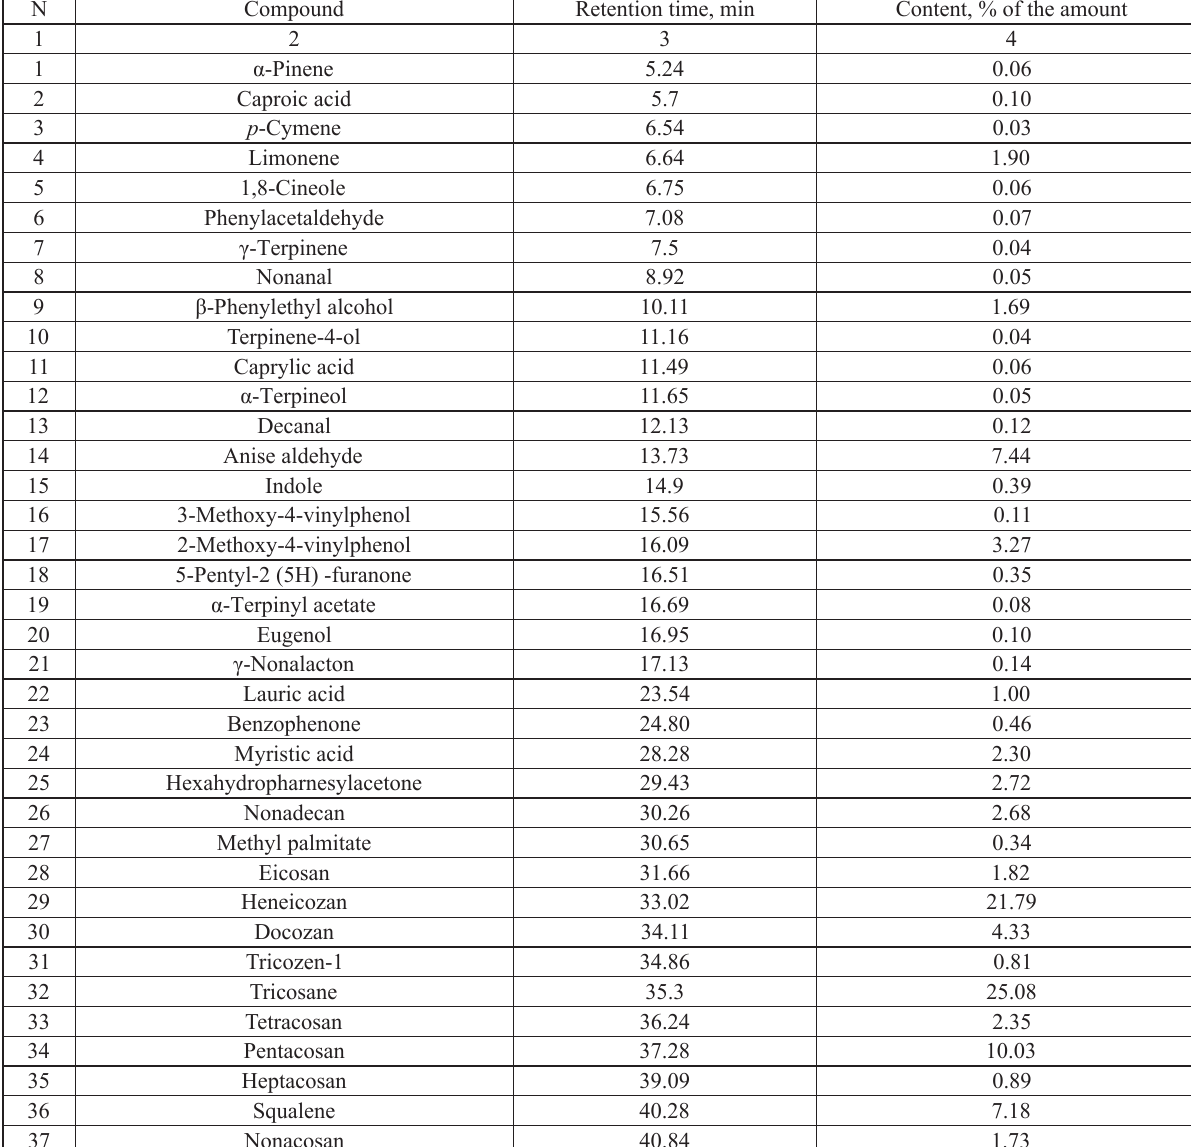
Component composition of essential oil of flowers Crataegus monogyna